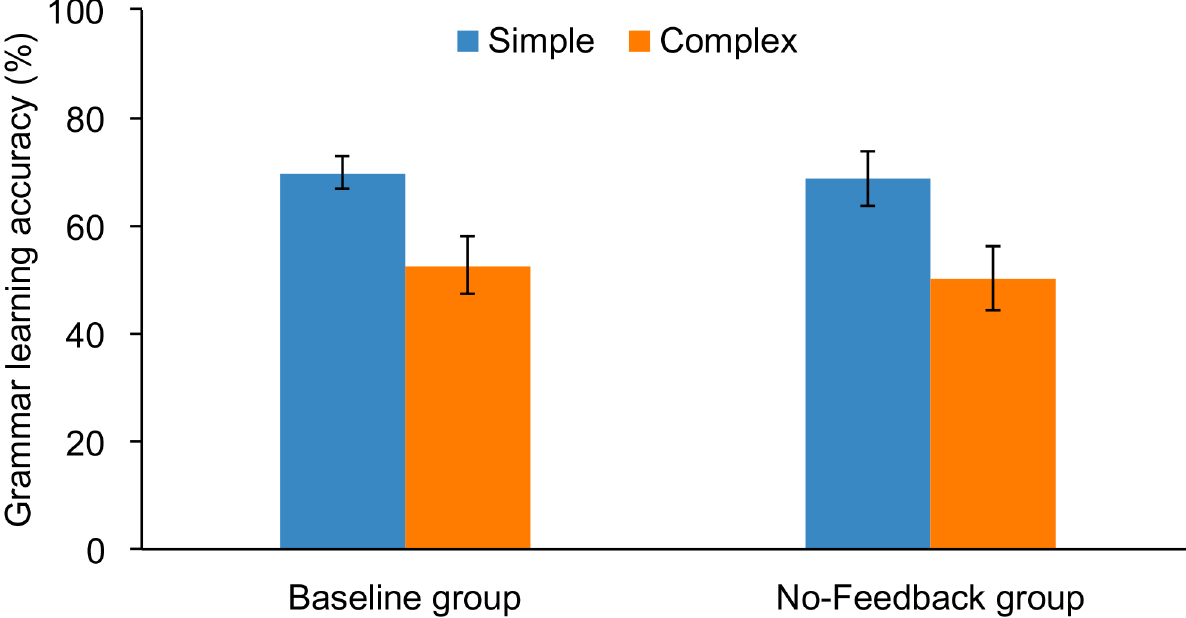
Fig 3. Grammar learning accuracy (%) of simple and complex grammar rules by subjects who were tested with or without feedback (baseline vs. no-feedback groups, respectively). Error bars depict standard errror of the